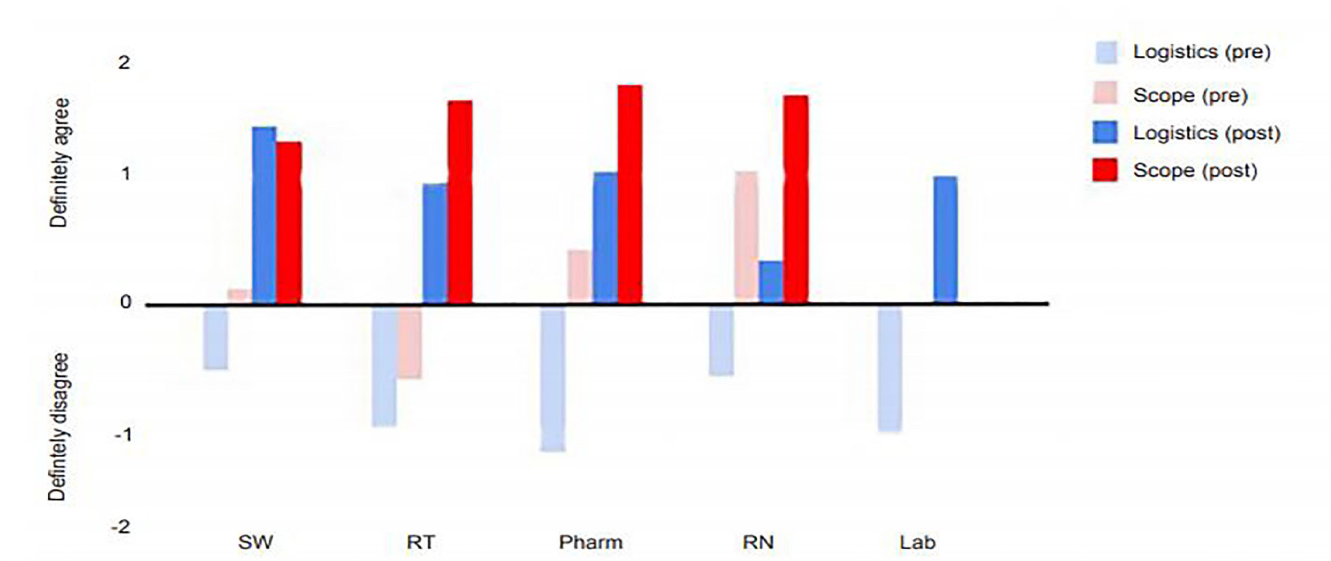
Figure. Survey results by specialty from the pre-and post-program survey taken by interns after they participated in an allied health professions program designed to enhance their understanding of the work done by non-physician team members in the emergency